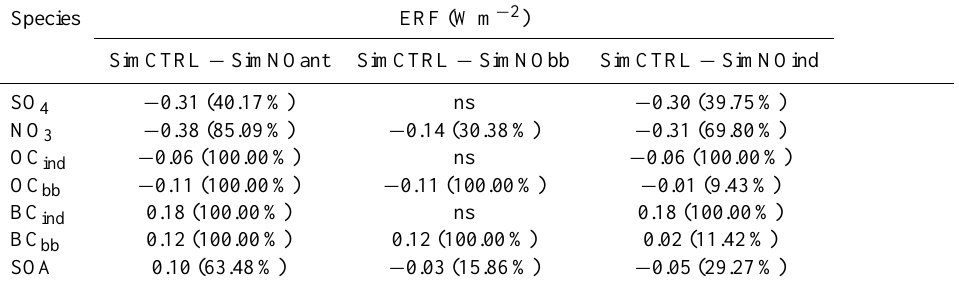
Table 2. Global annual average of effective radiative forcing (ERF) for aerosol–radiation interactions (Wm − 2 ) as simulated by NASA ModelE2-YIBs in present-day simulations for, in order, sulfates, nitrates, organic (OC) and black carbon (BC) from industrial (ind) and biomass burning (bb), and secondary organic aerosols (SOA). The global annual average ERF is calculated as the difference between the control experiment (SimCTRL) and sensitivity experiments: SimNOant, without all anthropogenic emissions; SimNObb, without biomass burning emissions; and SimNOind, without anthropogenic emissions except biomass burning. Percentage values in parentheses specify the contribution of target emissions (i.e., anthropogenic, biomass burning, and non-biomass burning) to the ERF of the selected aerosol component. The abbreviation “ns” indicates differences that are not statistically significant at the 95% confidence level (based on a Student’s t